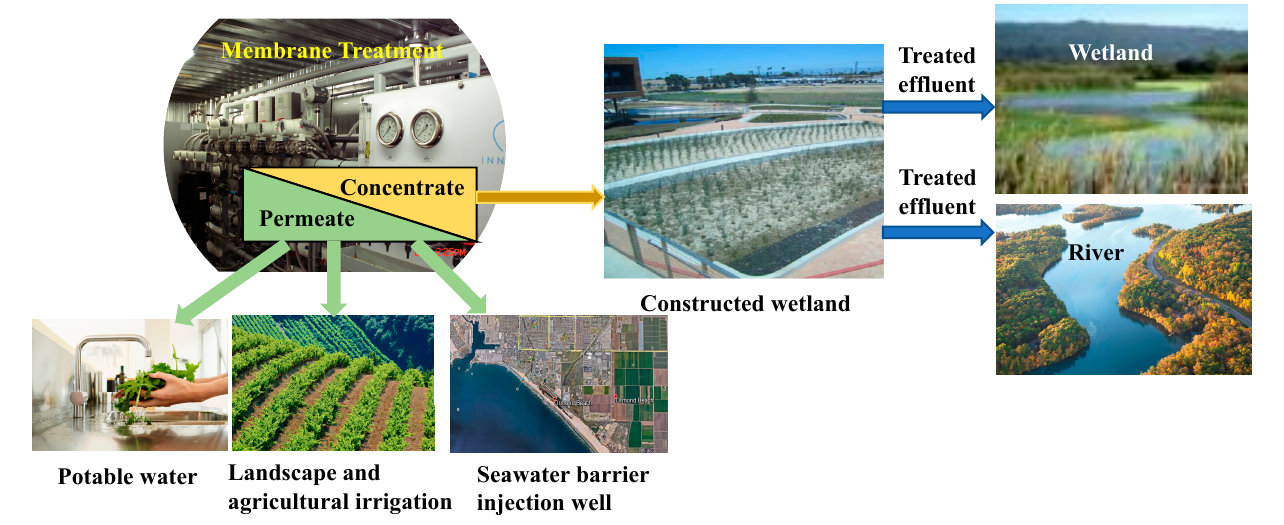
Figure 4. Schematic of the management of the membrane treatment for the permeate and concentrate at the